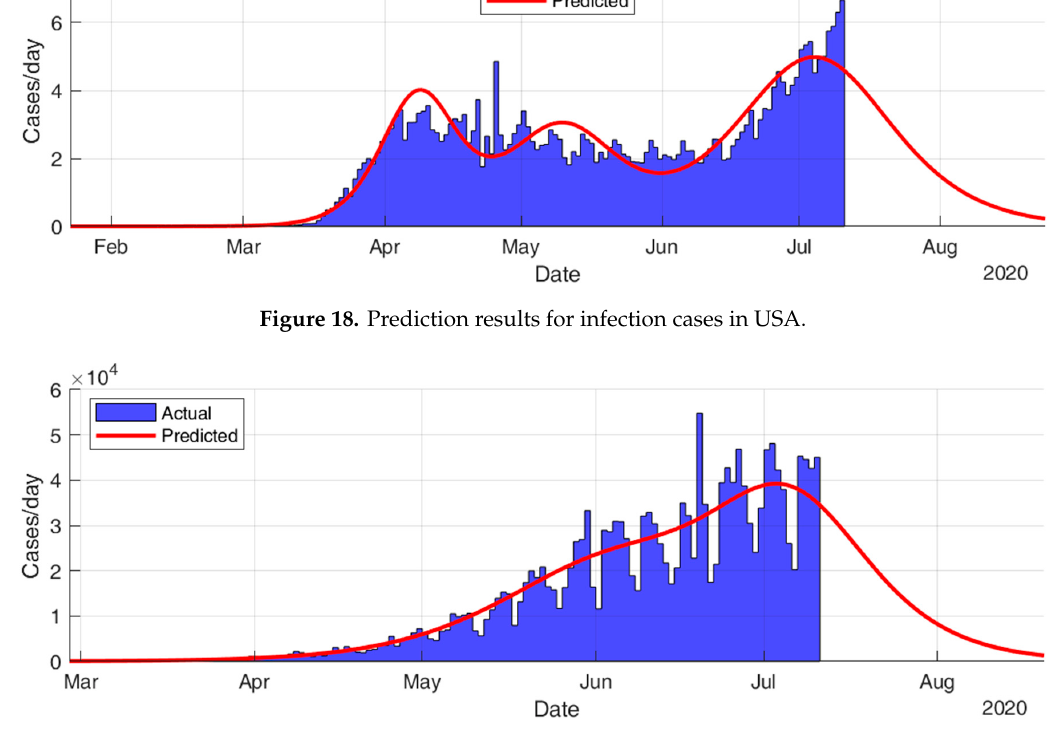
Figure 19. Prediction results for infection cases in Brazil.